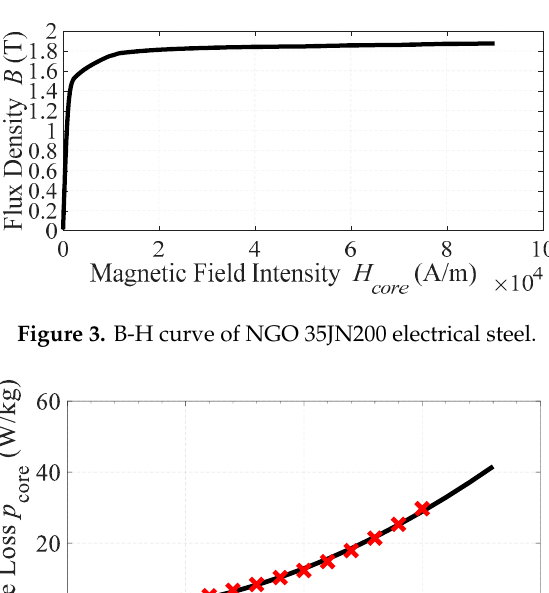
Table 2. Mechanical properties of NGO 35JN200 electrical steel.